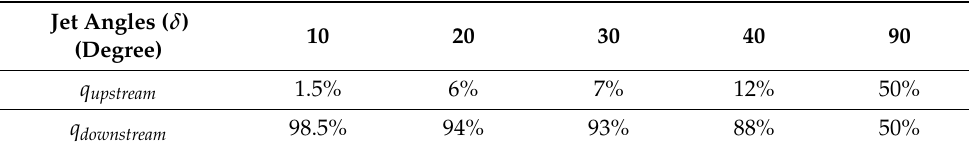
Table 12. Upstream and downstream strayed pieces of the absolute discharge rate for various points of impingement δ [86].